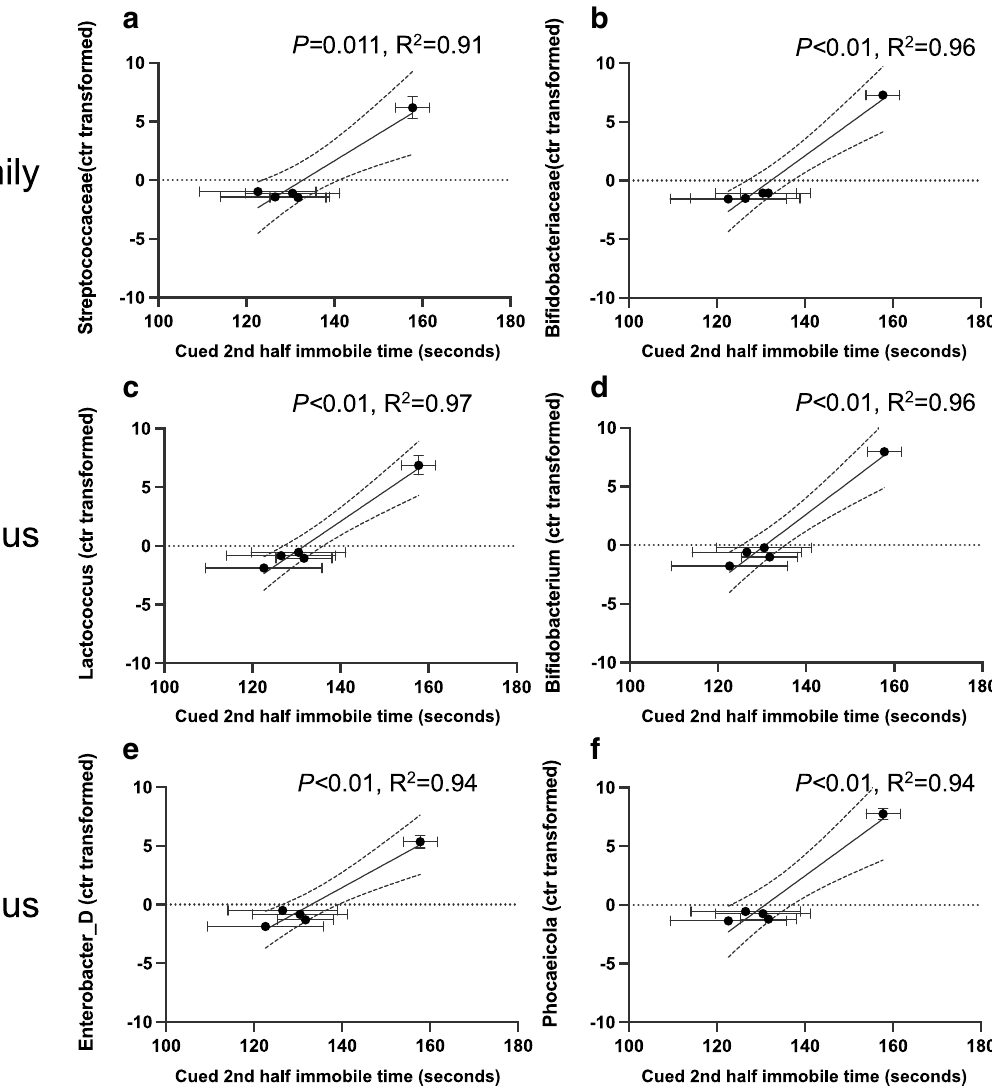
Figure 6. Specific bacterial taxonomic composition at 4 weeks old promoted cued fear retention. The relative abundance of Streptococcaceae ( a ) and Bifidobacteriaceae ( b ), Lactococcus ( c ) , Bifidobacterium ( d ) , Enterobacter_D ( e ) and Phocaeicola ( f ) in the fecal samples of 4 weeks old mice and the immobile behavior were positively correlated (all reached p < 0.05 by Pearson’s correlation analysis).